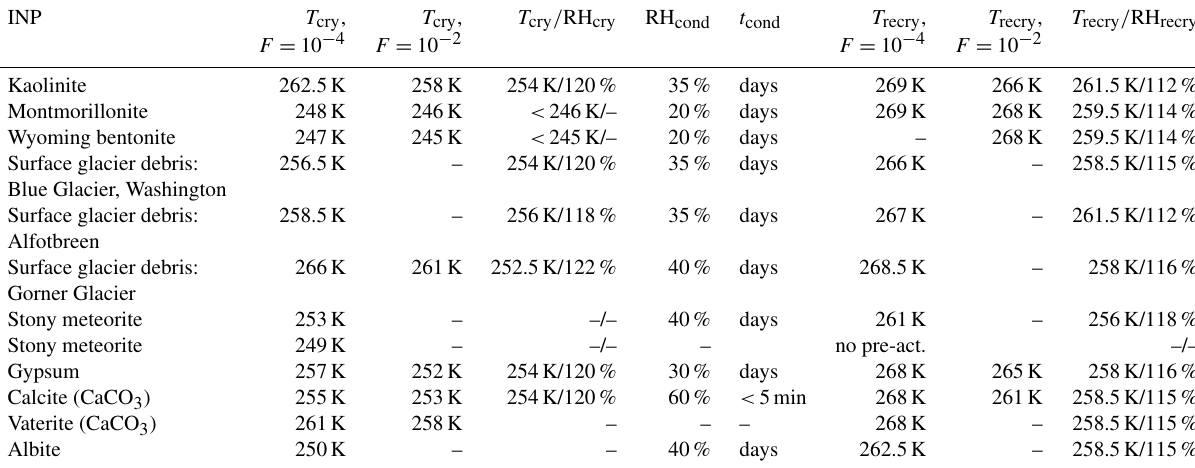
Table 6. Particles deposited on glass cover slips investigated by Roberts and Hallett (1968). T cry – crystallization temperature at S w for nucleated fractions of F = 10 − 4 and F = 10 − 2 ; T cry / RH cry – threshold crystallization temperature and RH with respect to ice for nucleation below S w ; RH cond – conditioning RH with respect to ice; t cond – conditioning time; T recry / RH recry – threshold recrystallization temperature and RH with respect to ice for nucleation below S w